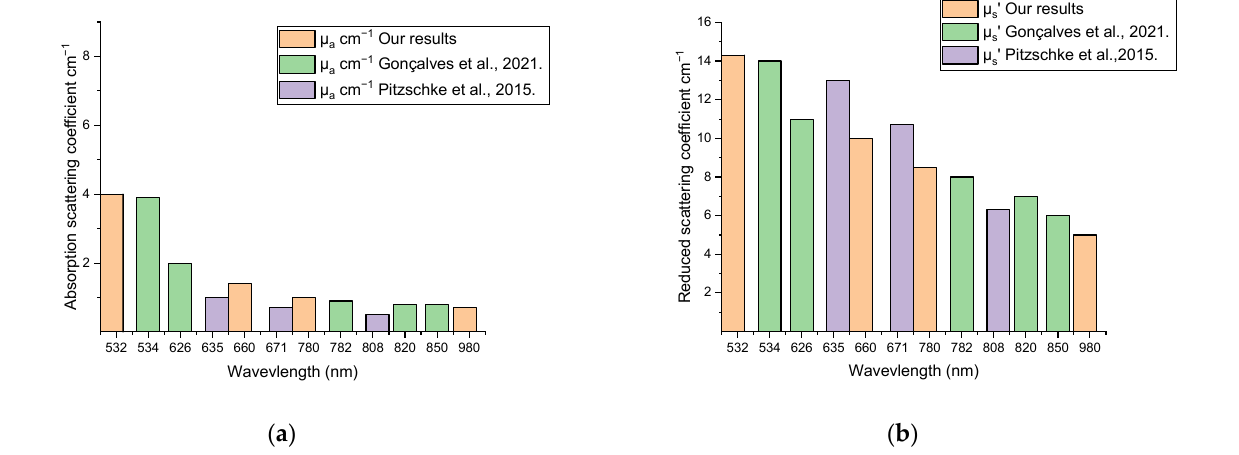
Figure 13. Comparison with the data from the literature Gonçalves et al. [29] and Pitzschke et al. [37] measured using the absorption coefficient µ a ( a ) and reduced scattering coefficient µ (cid:48) s ( b ) of the rabbit brain.